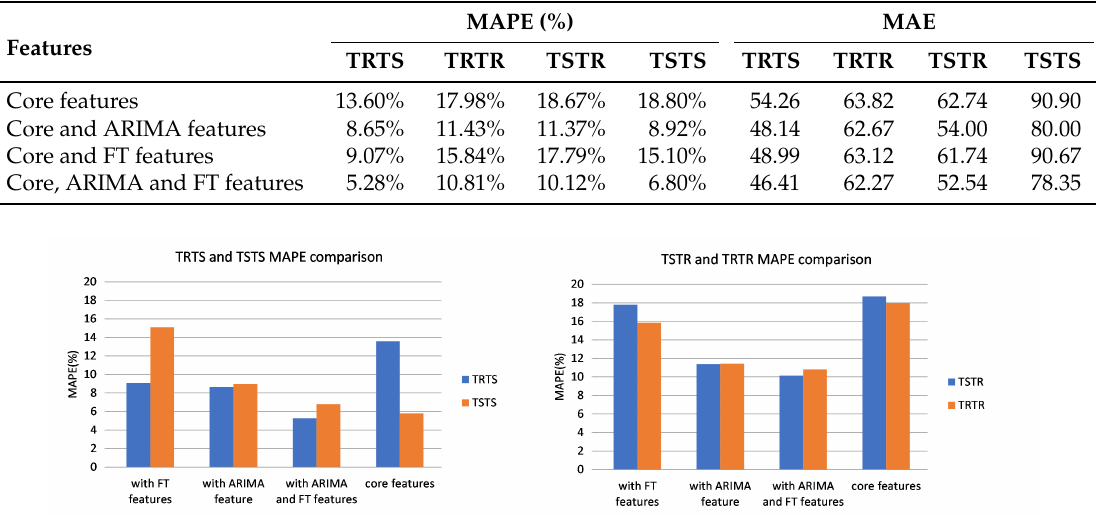
Figure 10. MAPE(%) comparison between TRTS/TSTS and TSTR/TRTR (UCI data set).